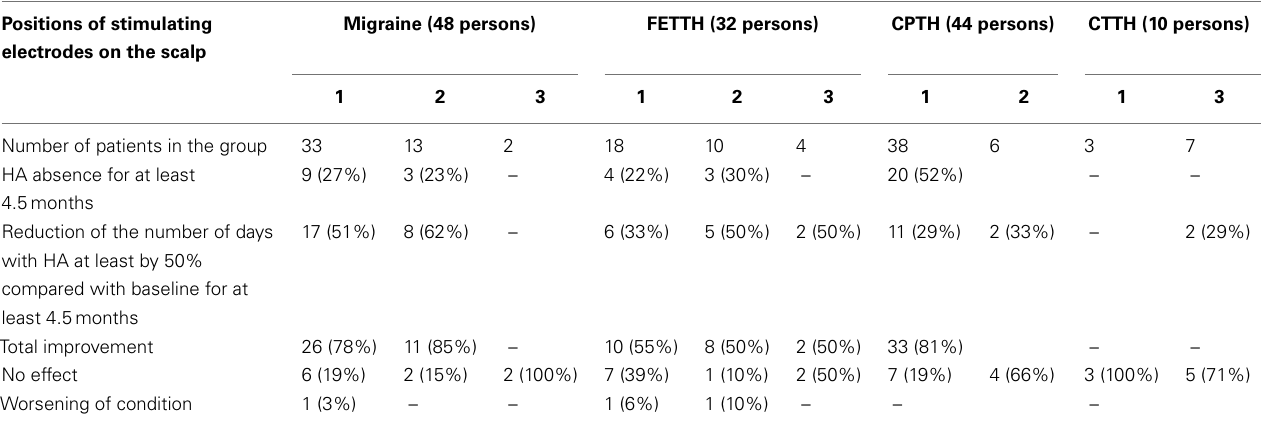
Table 2 | Effectiveness of treatment with various localizations of stimulating electrodes on the scalp for various HA